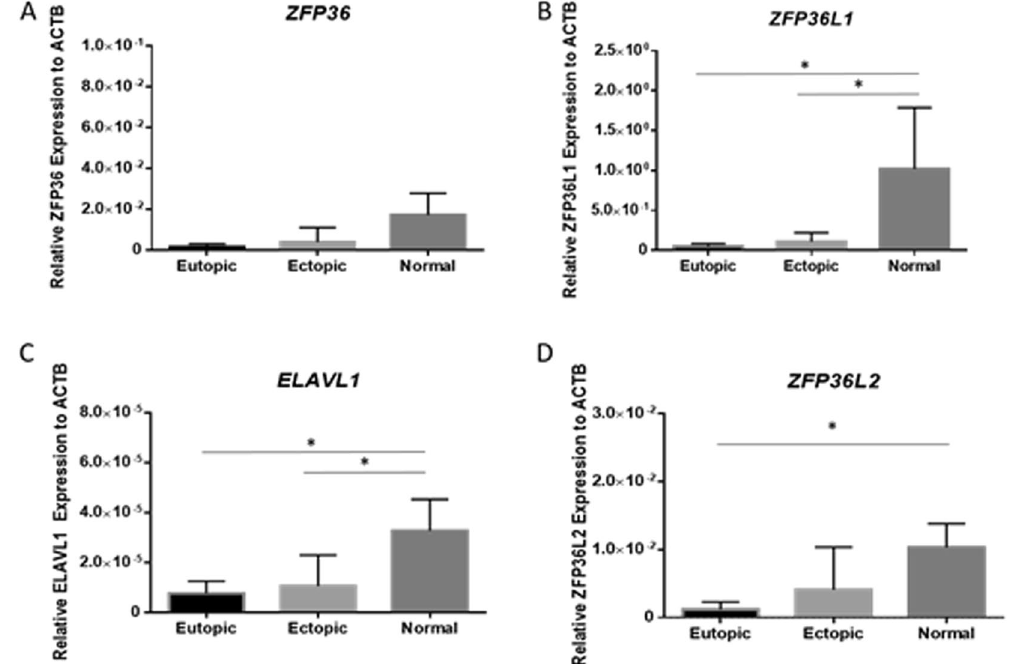
Figure 1. HuR/TTP axis mRNA levels are altered in patients with endometriosis: RNA binding protein expression profiles in endometriosis patients and in normal fertile controls. mRNA transcripts for ZFP36 remain unchanged (Panel A). Transcripts for ZFP36L1, ELAVL1 were significantly downregulated in eutopic and ectopic endometrium from endometriosis patients when compared to normal endometrium from fertile healthy controls (Panels B,C). Transcripts for ZFP36L2 was significantly downregulated in eutopic endometrium from patients with endometriosis compared to fertile healthy control women (Panel D). Expression data illustrated as mean ± SEM. * P < 0.05. Sample groups consisted of n = 22 human eutopic endometrium, n = 22 human ectopic endometriotic lesions, and n = 16 normal control